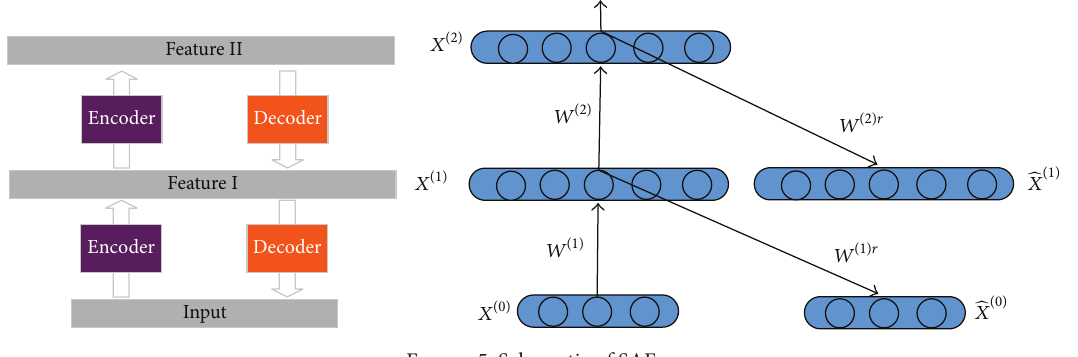
Figure 5: Schematic of SAE.